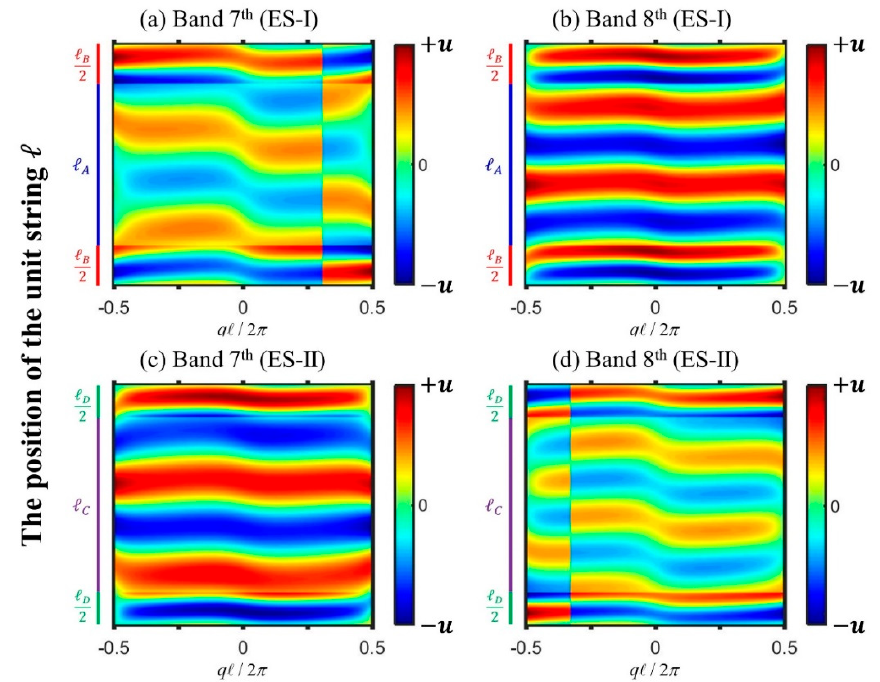
Figure 5. The four panels show the vibration modes of ES-I and ES-II in q space. The results for the 7th and 8th bands of ES-I are shown in ( a , b ). The results for the 7th and 8th bands of ES-II are shown in ( c , d ). The two discontinuities in ( a , d ) correspond to the singularities in the Zak connection evolution (Figure